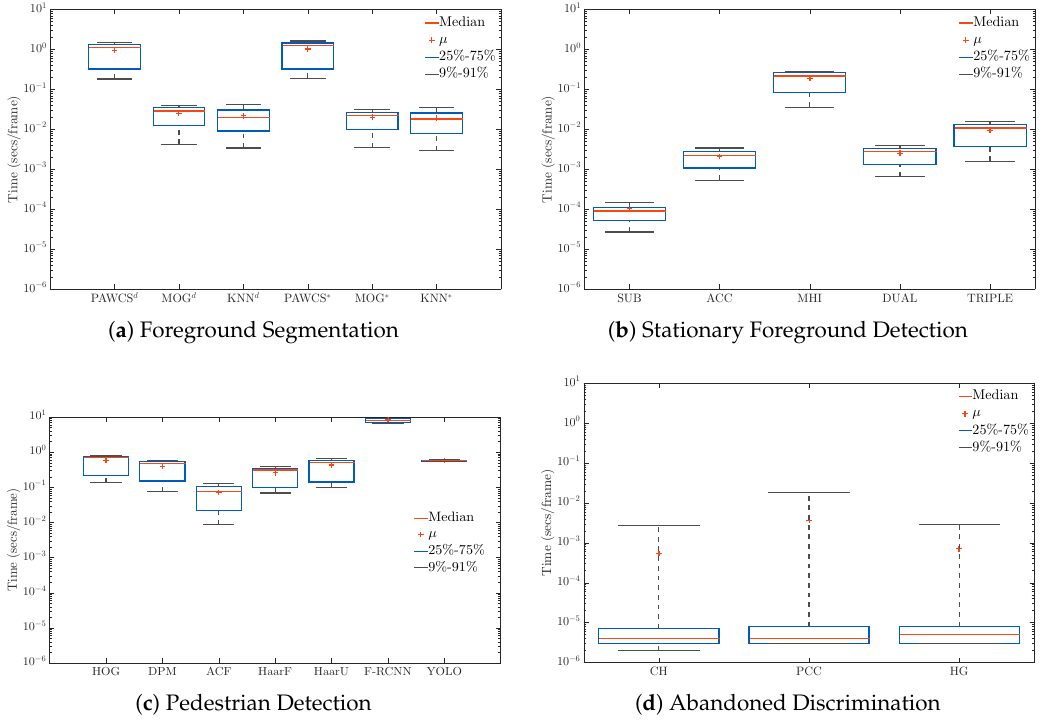
Figure 15. Computational cost analysis, in terms of seconds per frame, of every algorithm implemented at each stage: Foreground Segmentation ( a ), Stationary Foreground Detection ( b ), Pedestrian Detection ( c ) and Abandoned Discrimination ( d